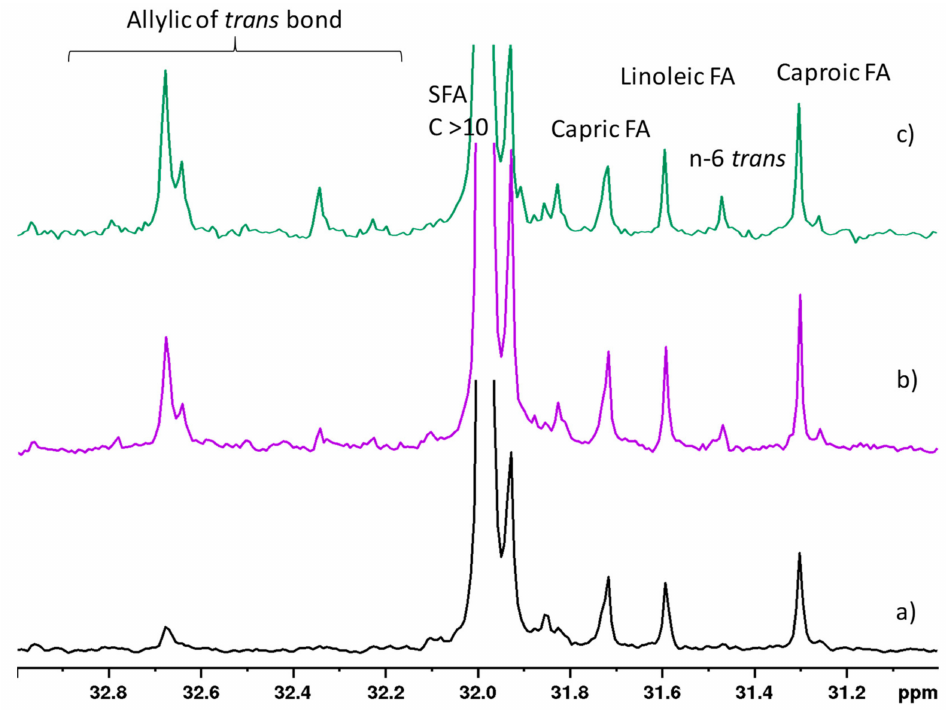
Figure 6. Expanded region of 400 MHz 13 C-NMR spectra of goat milk lipid fraction from ( a ) control, ( b ) hempseed, and ( c ) linseed diets in CDCl 3 at 298 K. Resonances highlighted with symbols refer to changes due to